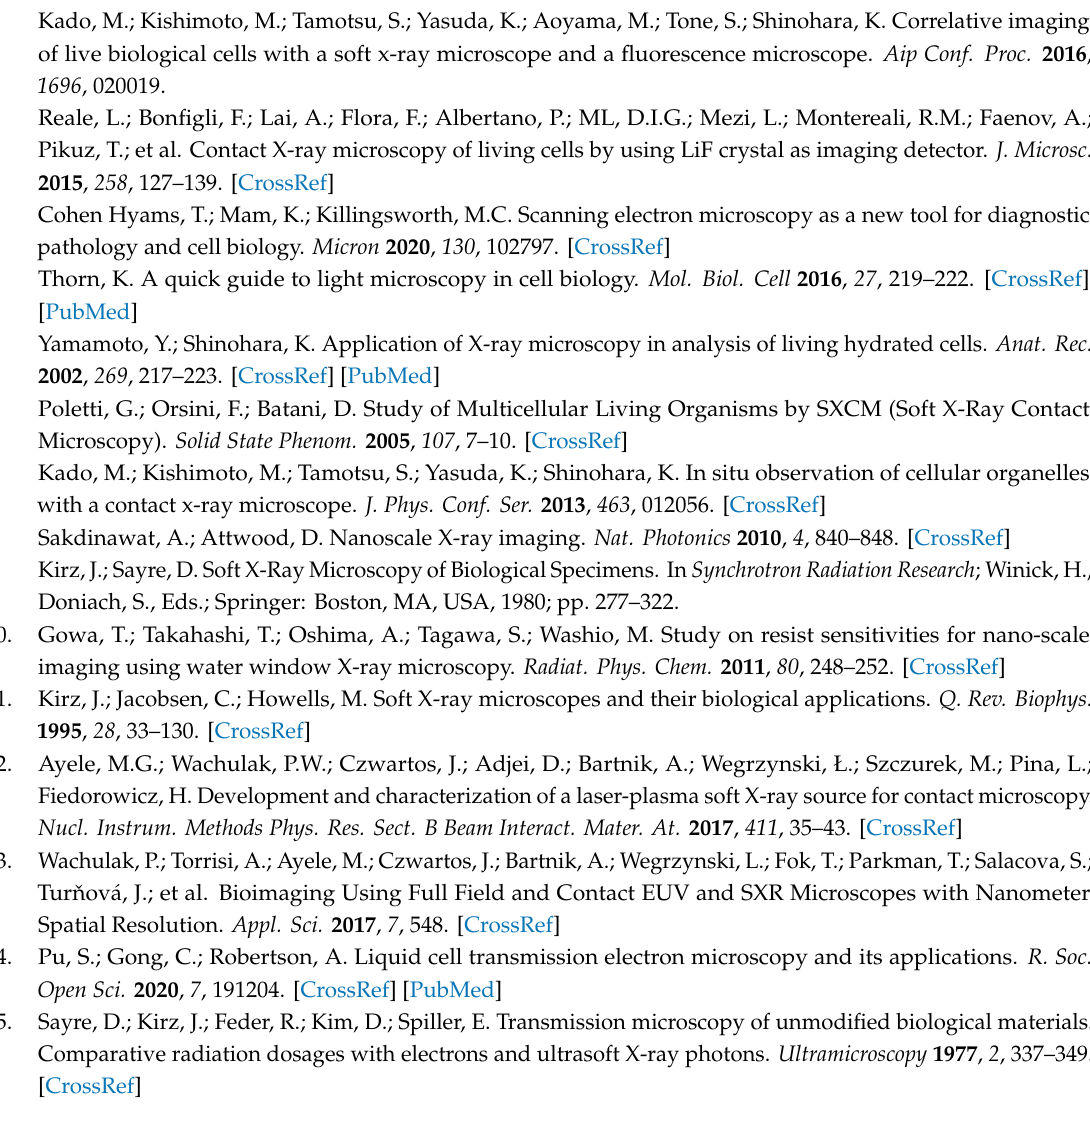
Figure S1: AFM images of DU145 cells saved on the PMMA photoresists by soft X-ray contact microscopy. Images were obtained after the exposure to 400 SXR pulses. Imprints were recorded by AFM (di CPII, Veeco) working in tapping mode. Scan size of 25 × 25 µ m 2 . Insets: fragments of the cell showing detailed structures (image size 5 × 5 µ m 2